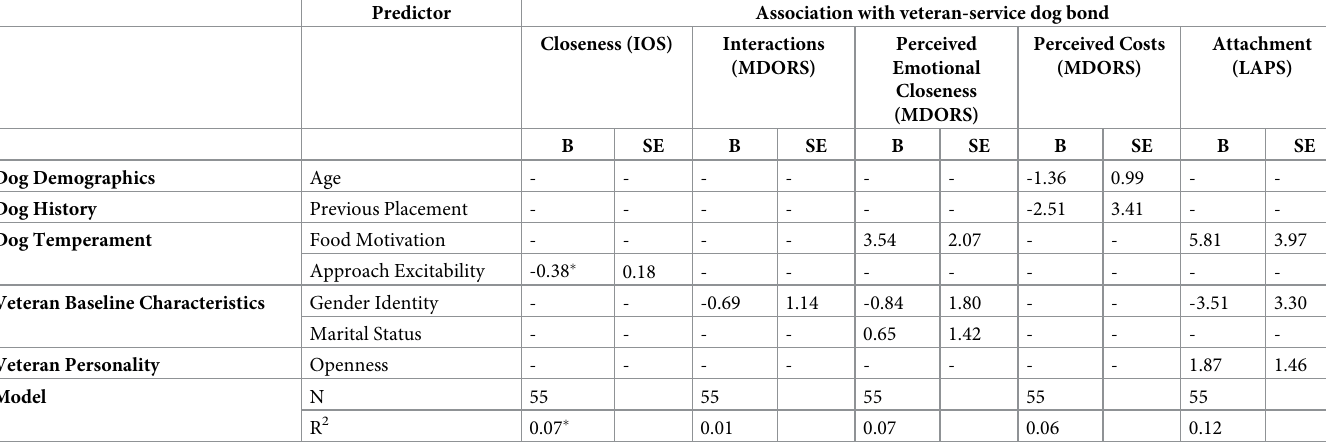
Table 6. Regression outcomes for Aim 2 (predicting veteran-service dog bond), after variable selection by elastic